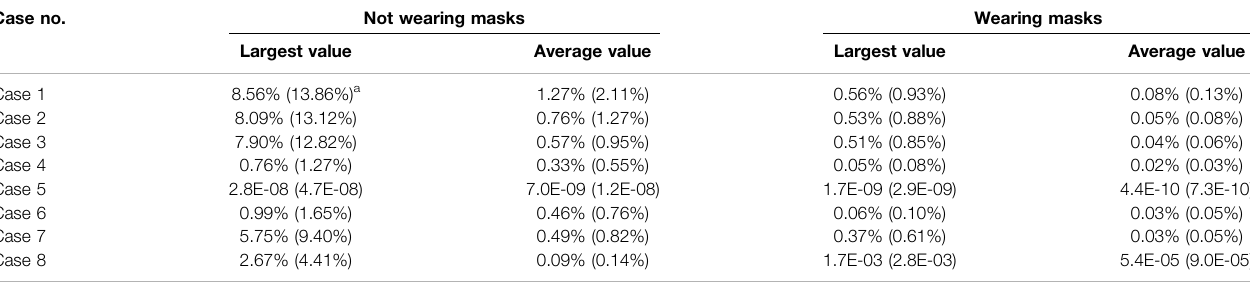
TABLE 3 | Probability of infection when quanta emission rates are 30 and 50 quanta/h. Case